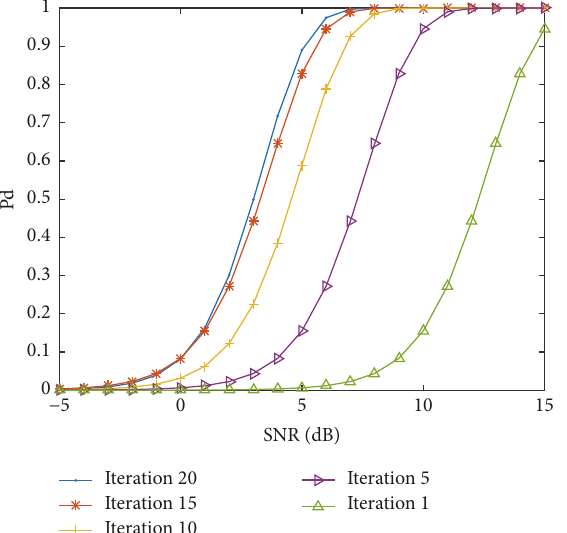
Figure 5: Detection probability for various iterations of the Kalman filtering approach.